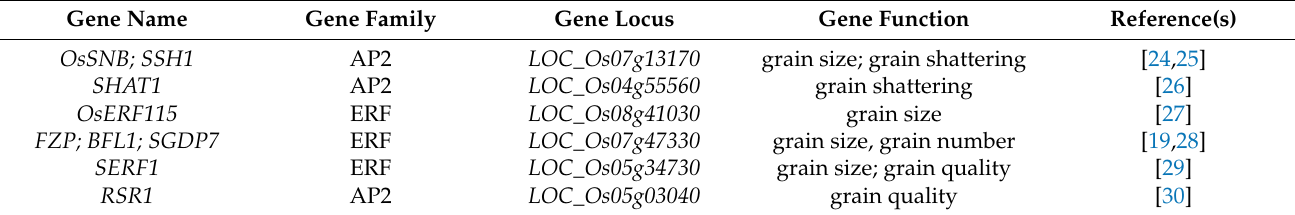
Table 4. Genes associated with grain properties in